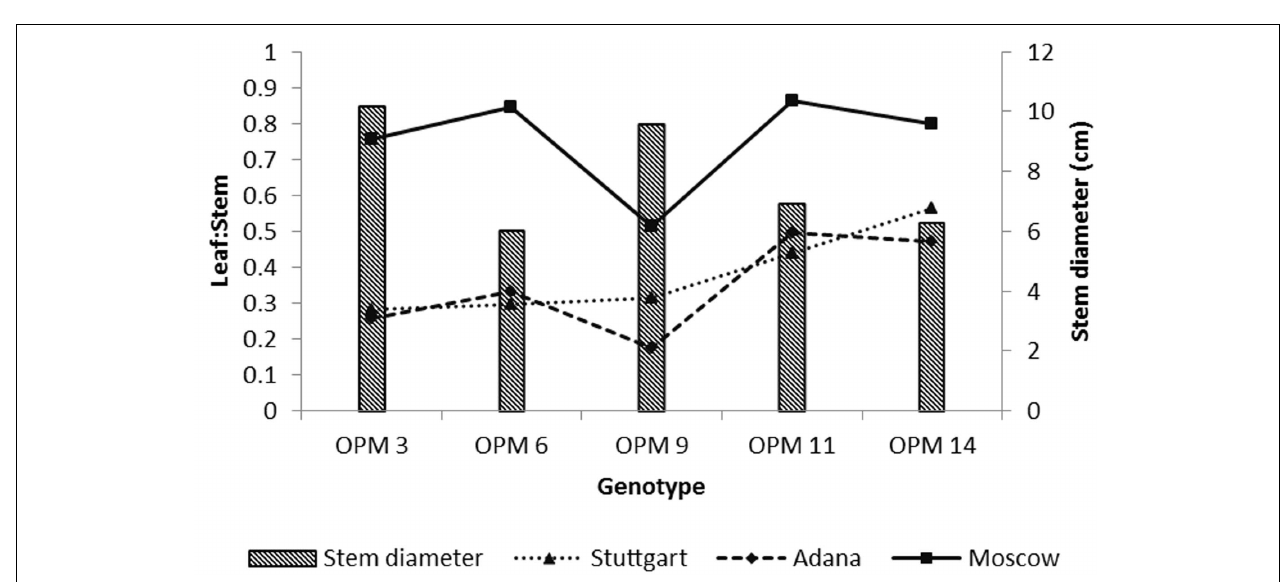
FIGURE 6 | Leaf-to-stem ratio (shown as lines) for selected miscanthus genotypes at three sites (mean of all harvest dates) and stem diameter (shown as bars) for Stuttgart only (final